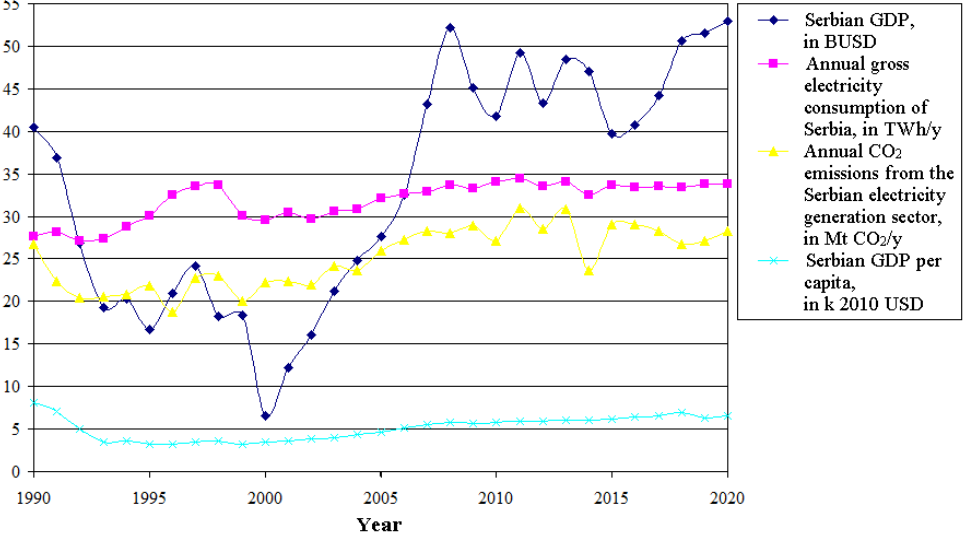
Figure 2. Changes in the parameters relevant for determining the Kaya identity factors [6,55,57–64].